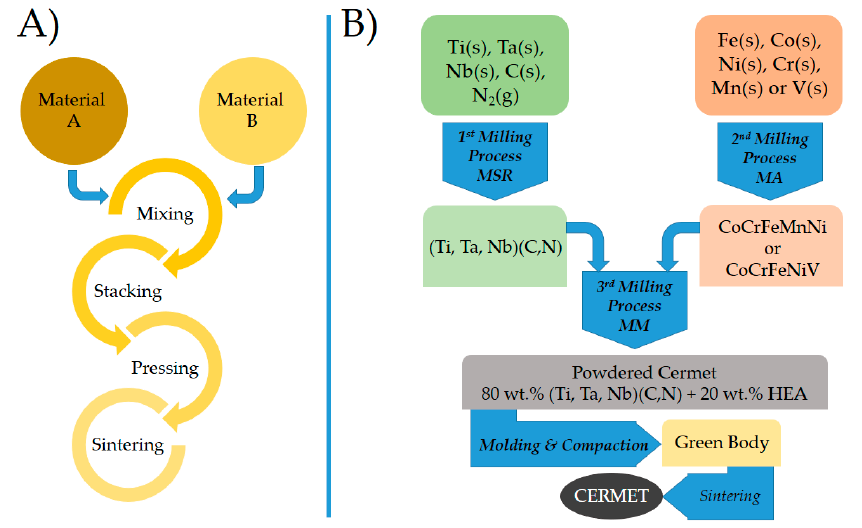
Figure 2. Steps in the synthesis of cermets: ( A ): traditional method, ( B ): advanced method. Adapted from Refs. [26,31].